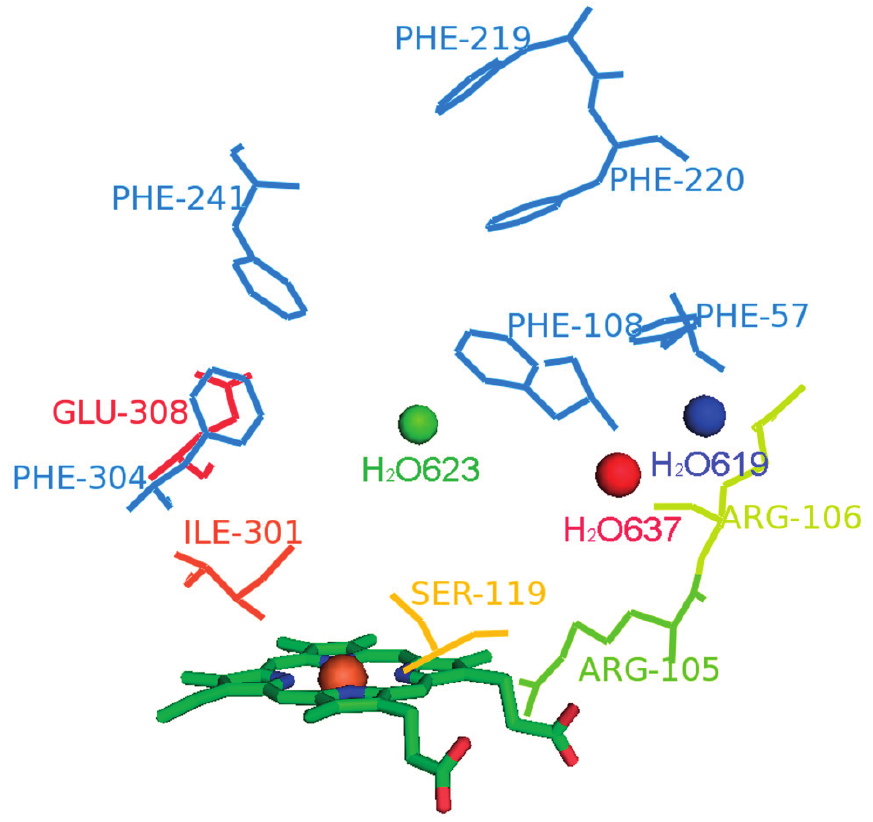
Figure 5. Representative interaction features in CYP3A4 active conformation. Shown are six hydrogen bonds (three water as spheres and three residues as magenta lines), six hydrophobic features (blue line) and a heme